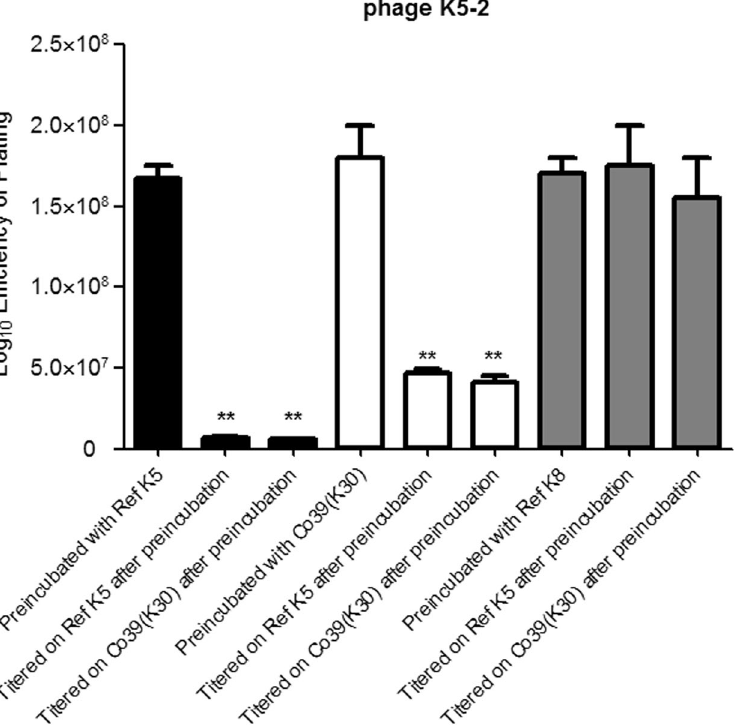
Figure 4. Adsorption experiments of phage K5-2. Preincubation of phage K5-2 with its host the K5 reference or Co39 (K30) strain and determination the viral titers on the reference K5 and Co39 (K30) strains, respectively. Negative reactions were observed on the reference K8 strain. The data represent the means of three independent trials; the error bars represent the standard deviations. ** P < 0.01 by Student’s t test (compared to the viral titer of the respective host before